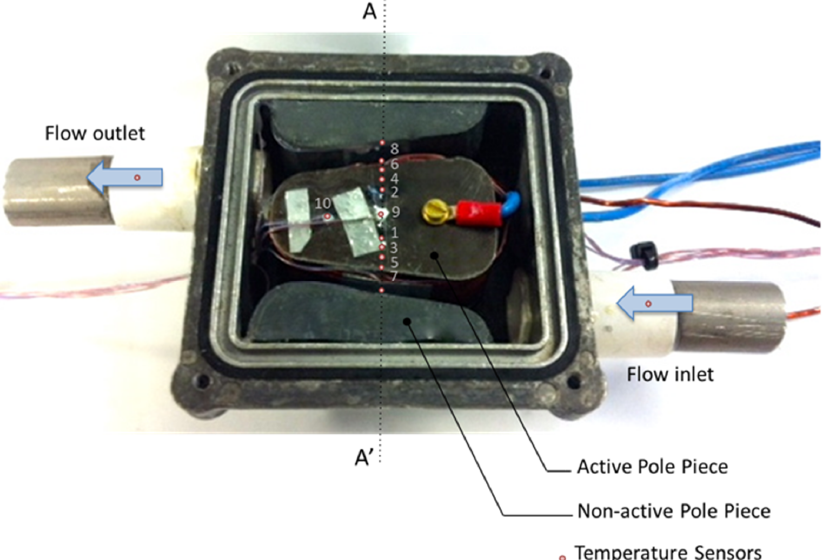
Figure 14. Test section recreating the flow geometry with the mounted instrumented pole piece. Line AA’ is used as a reference for the temperature profile.